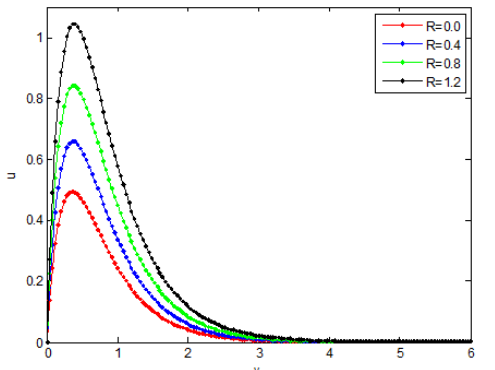
Figure 6. Effects of radiation parameter on the velocity profile of the Casson nanofluid